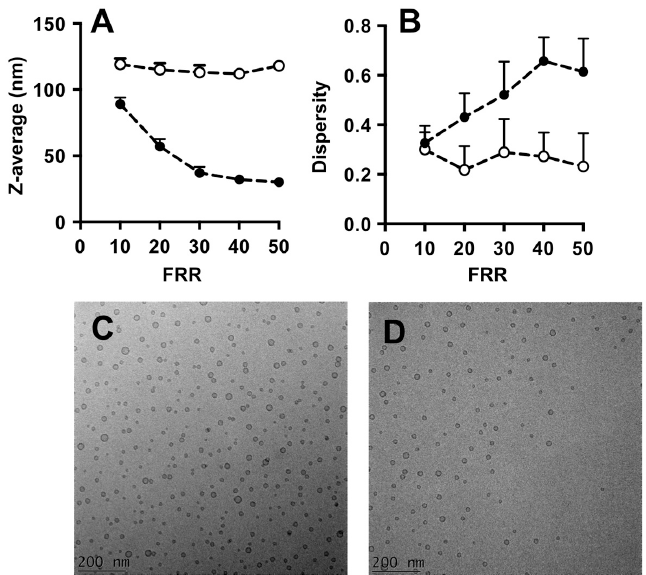
Figure 2. Dimensional characteristics of liposomes produced by microfluidics: Z-average ( A ) and dispersity ( B ). Liposomes were prepared by #chip1-MHF (filled circles) or #chip2-YJ (open circles). Experimental conditions and lipid composition are described in the methods section. Data represent the average of 3 batches, measured in triplicate ± SD; Cryo-TEM images of liposomes produced using #chip1-MHF ( C ) and #chip2-YJ ( D ) are reported, for a FRR of 10 and TFR of 37.5 µL/min.